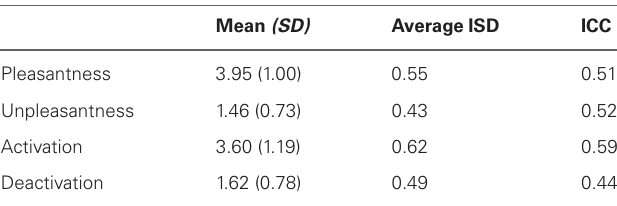
Table 2 | Descriptive statistics of the four factors of affect (measured on a five-point Likert-scale from 1 to